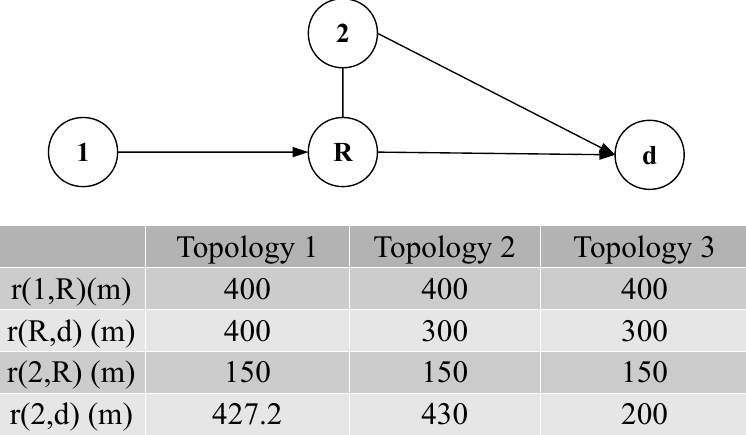
Figure 2. A summary of the considered wireless network